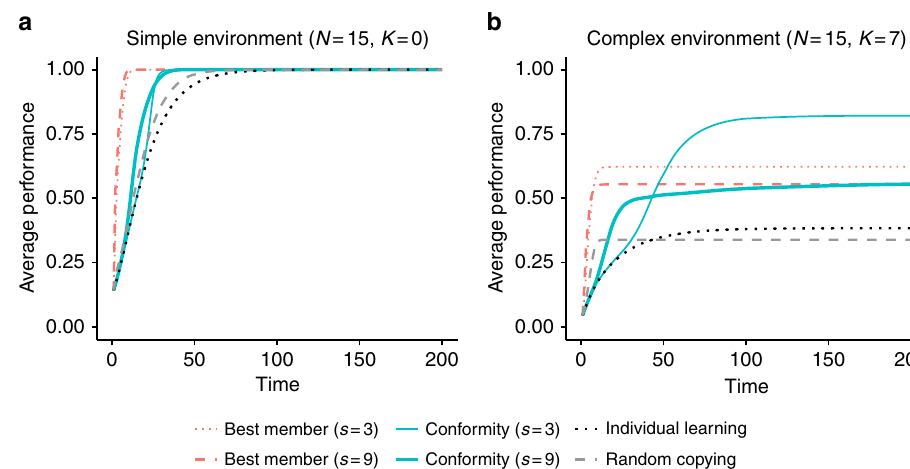
Figure 1 | Performance over time for different strategies in a fully connected network. N denotes the number of components of the system and K represents the number of interdependent components (see Methods); s stands for sample size. ( a ) Simple environment with a global optimum and ( b ) complex environment with multiple local optima. Red dotted lines: best member ( s ¼ 3); red dashed lines: best member ( s ¼ 9); turquoise thin lines: conformity ( s ¼ 3); turquoise thick lines: conformity ( s ¼ 9); black dotted lines: individual learning; grey dashed lines: random copying. Based on n ¼ 100 agents and 1,000 repetitions.